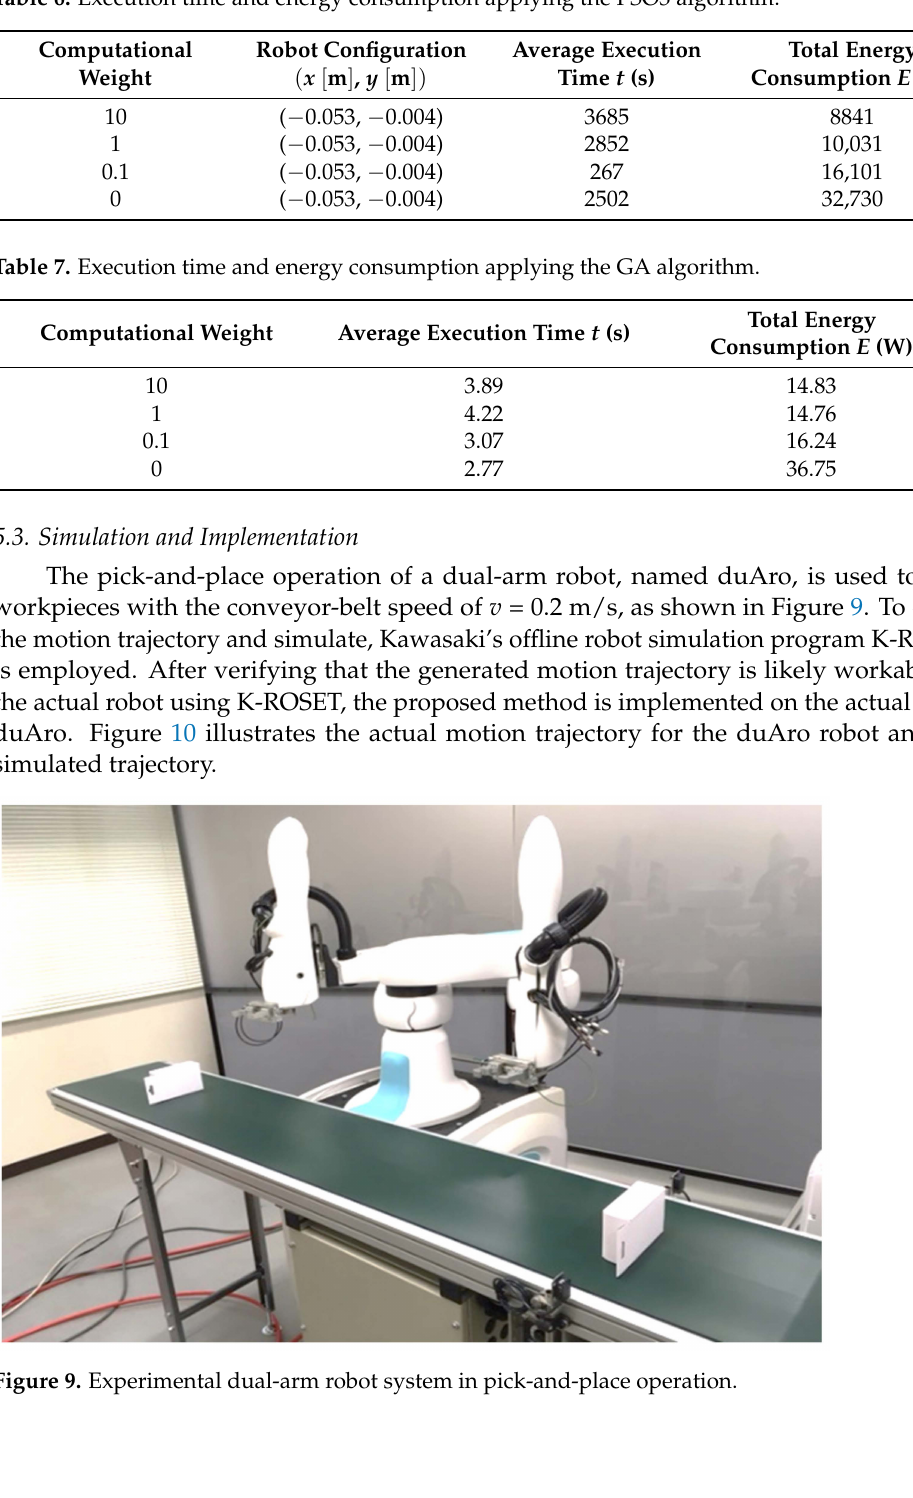
Table 6. Execution time and energy consumption applying the PSO3 algorithm.